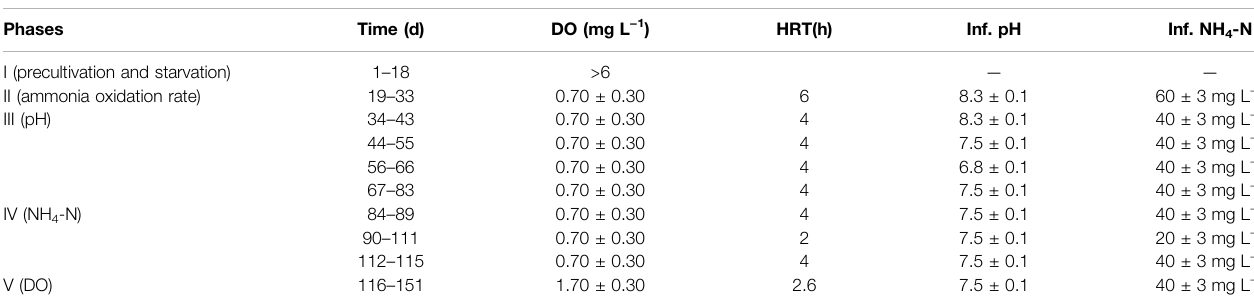
TABLE 2 | Operational parameters for phase I to